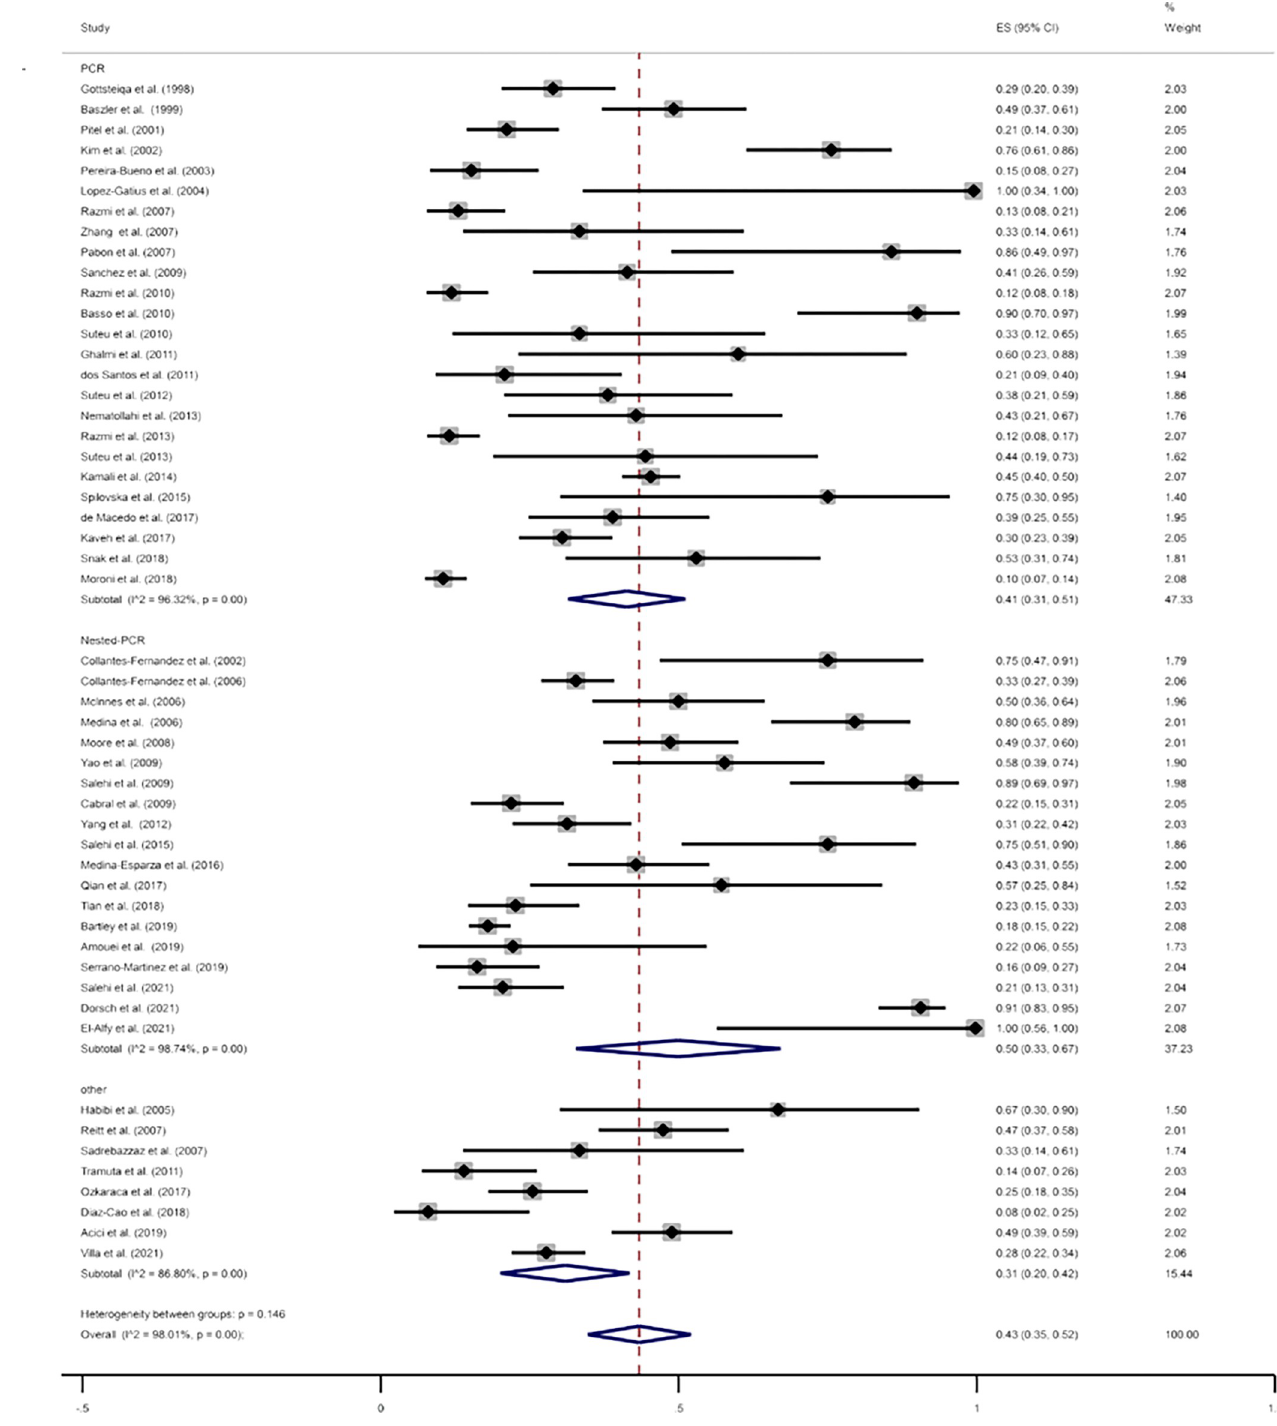
Fig 4. The prevalence of N . caninum infection in the bovine aborted fetuses using molecular methods.